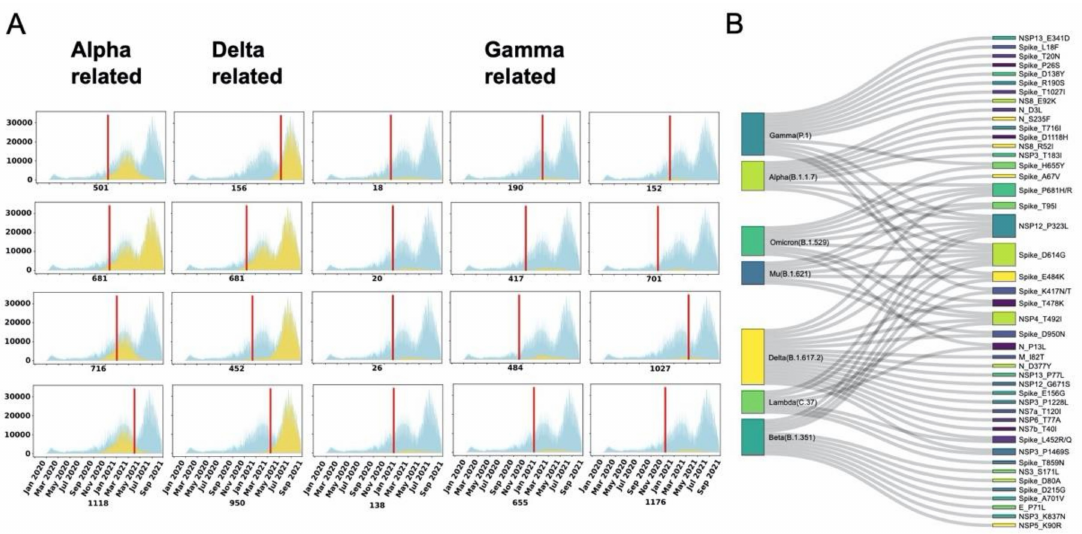
Figure 4. Surveillance of sites with paraFix mutations in different SARS-CoV-2 variants. ( A ) The epidemiological distribution of Alpha-related, Gamma-related, and Delta-related paraFix mutations. The blue area signifies the total isolated infections with time. The yellow area represents the infections with the specific mutation. The red line indicates the first timepoint when this site was recognized as a paraFix mutation. ( B ) The connections between different VOI/VOC variants and the observed paraFix